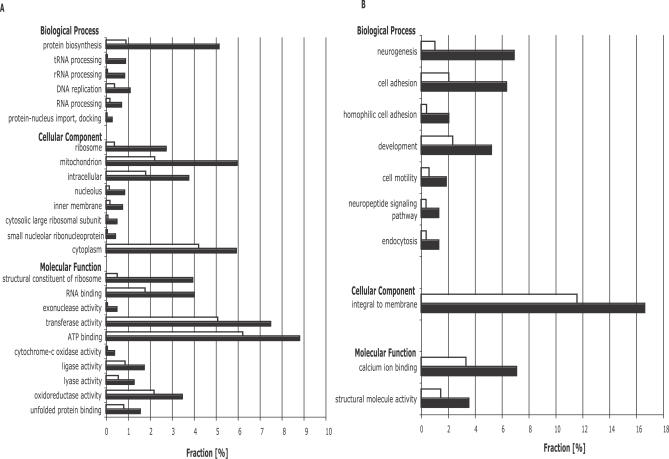
Gene Ontology AnalysisDifferential gene expression of hESCs (Cyt-ES and HUES6-ES) and NPs (Cyt-NP, HUES6-NP, and hCNS-SCns) was computed from gene-level signal estimates. Statistical significance for differential gene expression was determined by using t-statistics with Benjamini-Hochberg correction for false discovery rate (p < 0.01). Gene Ontology “molecular function,” “cellular component,” and “biological process” categories, which differed significantly (p < 0.05) in the representation between significantly enriched genes (black bars) and all other genes (white bars), were shown. Statistical significance for GO analysis was assessed by using χ2 statistics with Bonferroni correction for multiple hypothesis testing. GO categories are ordered from top to bottom in order of decreasingly significant bias toward enriched genes.(A) GO analysis of enriched genes in hESCs.(B) GO analysis of enriched genes in NPs.